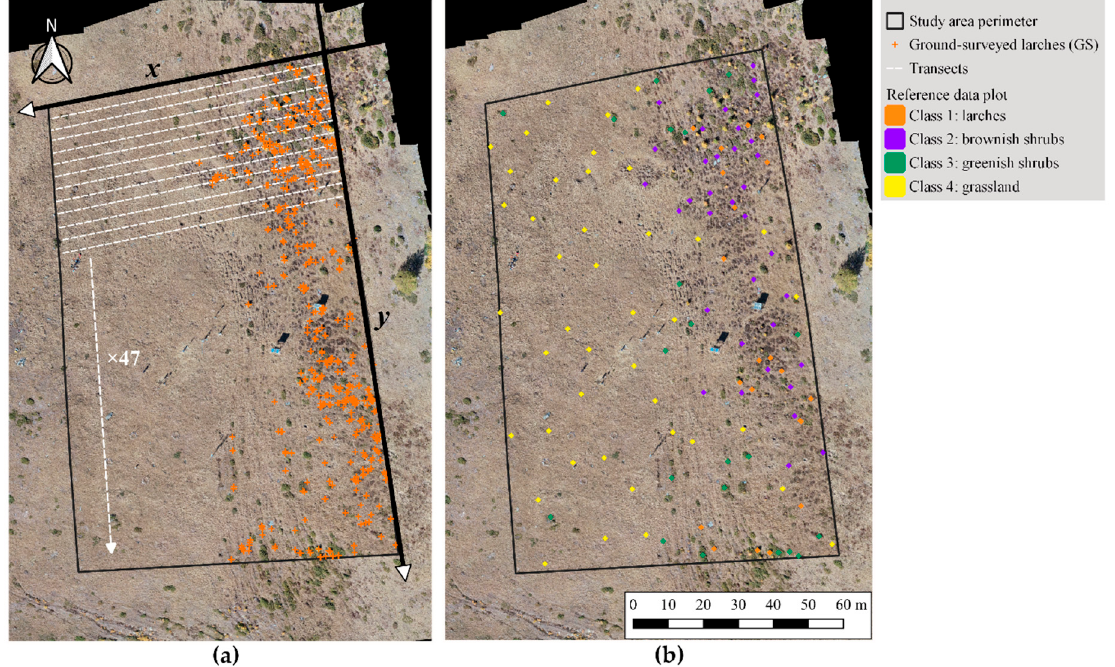
Figure 5. Sampling design of ground truth ( a ) and reference data ( b ) collection.